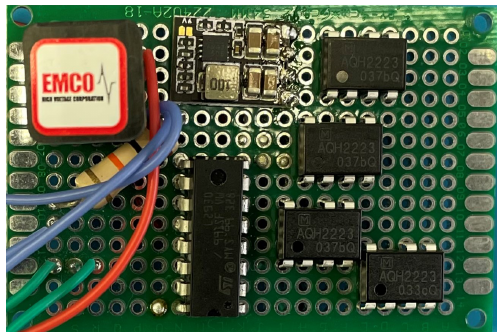
Figure 11. Real MFC Control